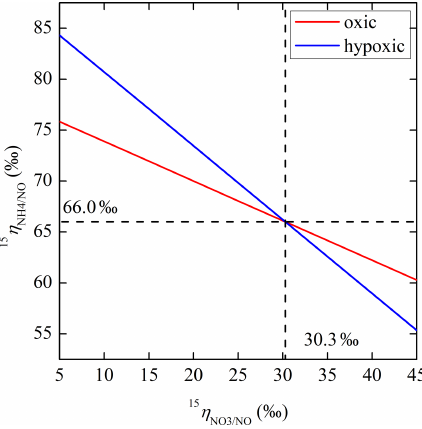
Figure 11. Relative magnitude of net N isotope effects for NO pro- duction from NH + oxidation ( 15 η NH ) and NO − consumption 4 3 4 / NO ( 15 η NO ) in the oxic and hypoxic 3 / NO